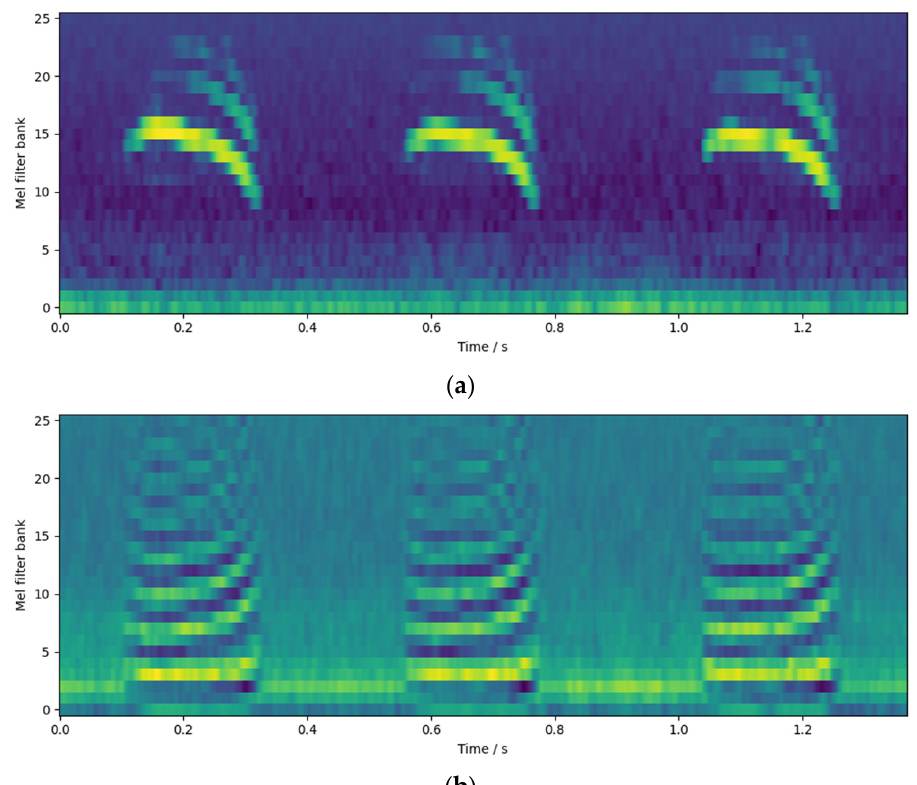
Figure 12. Example of feature group: ( a ) Logfbank; and ( b ) MFCC.